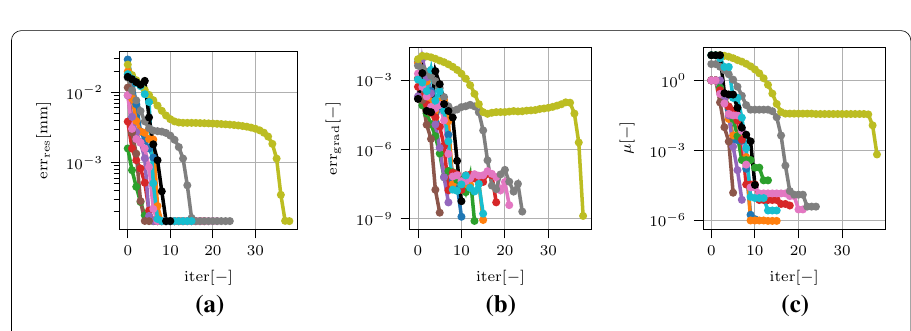
Fig. 6 Development of a residual error err res , b gradient based error err grad and c regularization parameter μ for inverse analysis runs with different initial guesses over iterations, with Gaussian noise with standard deviation σ = 10 − 4 mm added to the